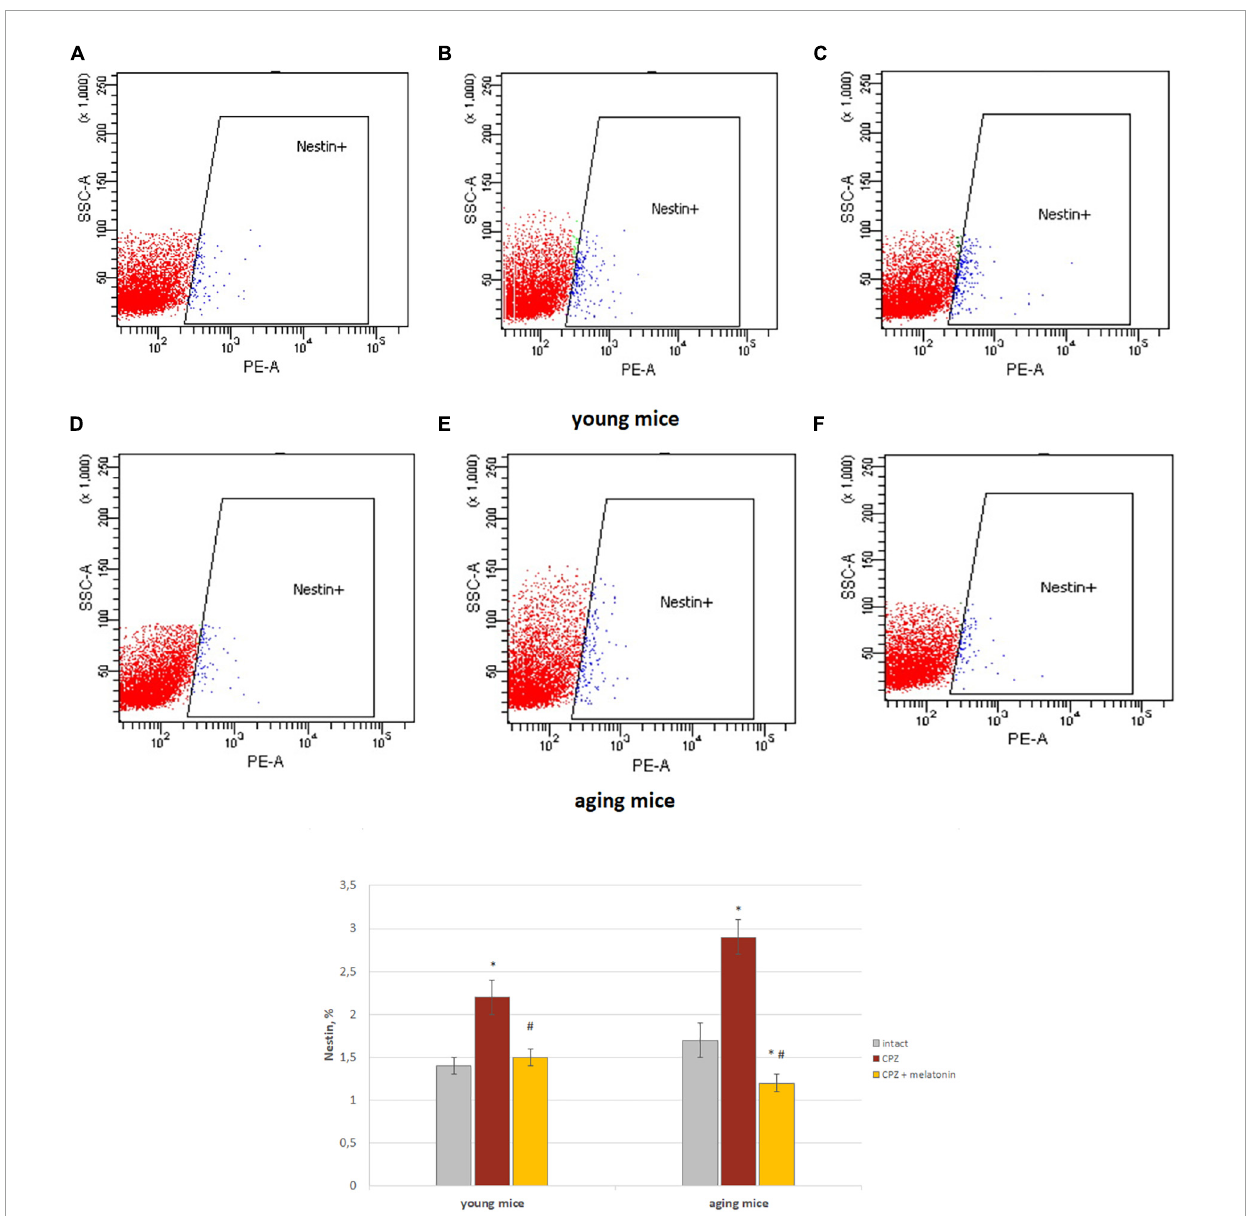
FIGURE5 Histograms of Nestin marker expression in the total brain cells according to low cytometry and the percentage of Nestin+ cells in the brain of young and aging mice of each experimental groups ( n = 5). (A,D) Intact groups; (B,E) cuprizone groups; (C,F) cuprizone + melatonin groups. Represented data are in 3 weeks of cuprizone (CPZ) diet. Data are M ± SEM. * p < 0.05 compared to intact group; # p < 0.05 compared to CPZ ( t -test).